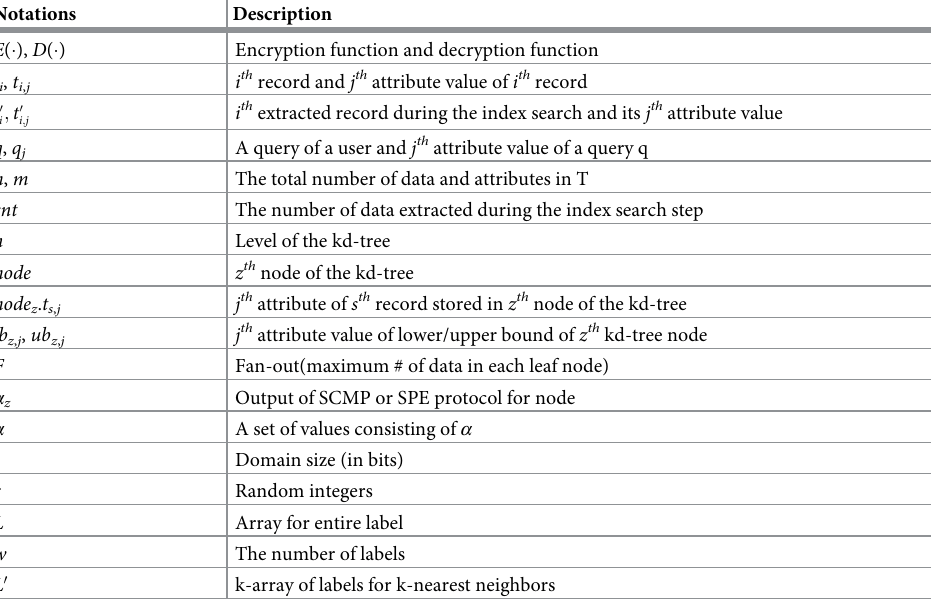
Table 2. Definitions of common